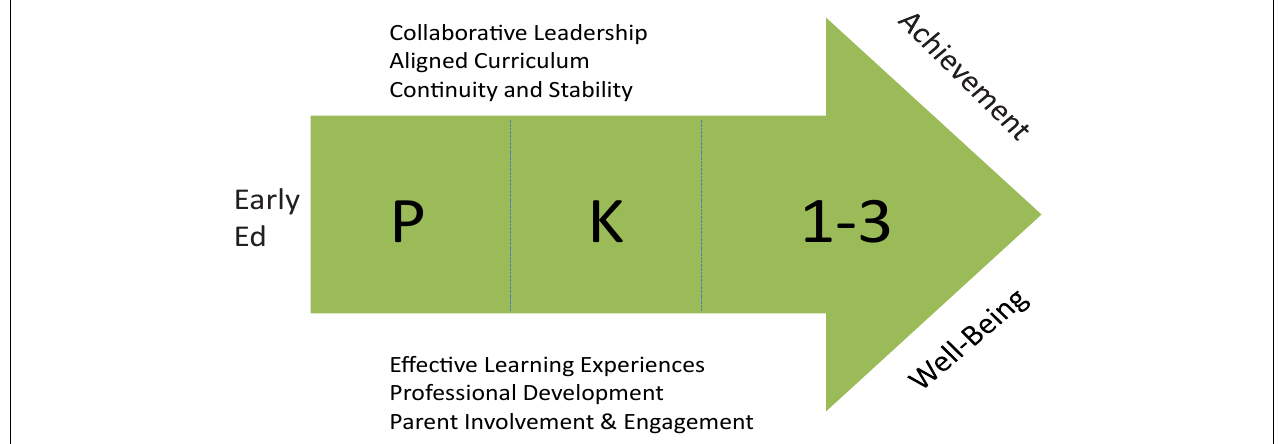
FIGURE 2 | CPC preschool to 3rd grade process. Key components of the school reform model with the dual goals of achievement and overall well-being. Early education begins at ages 3 or 4 with continuing services through 3rd grade. The six core elements are key to promoting developmental